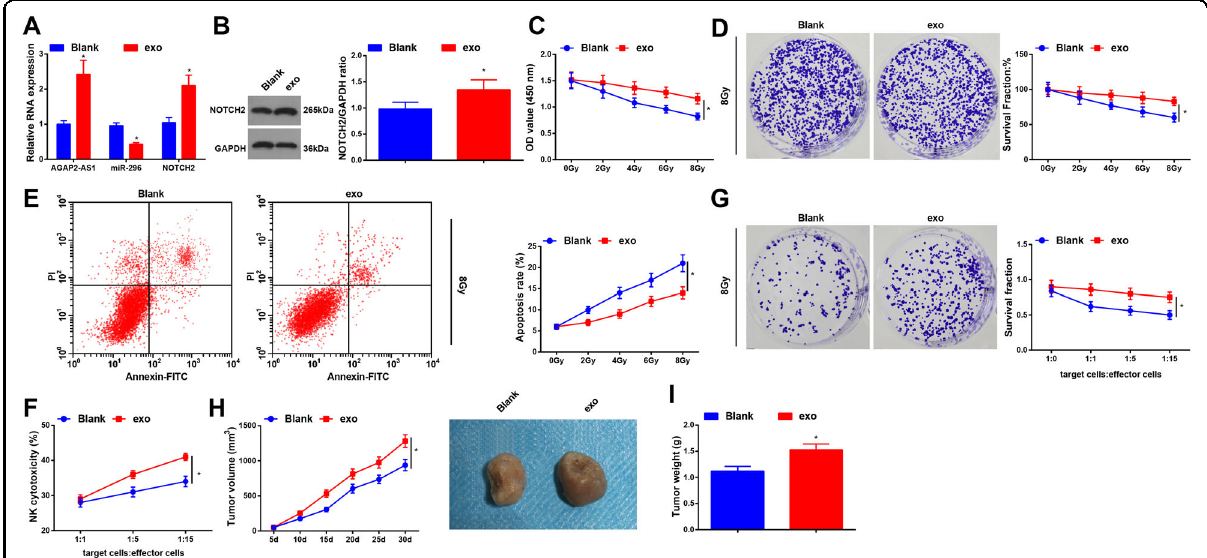
Fig. 5 Macrophage-derived exosomes strengthen radioresistance of radioresistant lung cancer cells. A Expression of AGAP2-AS1, miR-296, and NOTCH2 in A549R26-1 cells was detected by RT-qPCR. B Protein expression of NOTCH2 in A549R26-1 cells was determined by Western blot analysis. C Viability of radioresistant lung cancer cells A549R26-1 was measured using CCK-8 assay. D Colony formation ability of radioresistant lung cancer cells A549R26-1 was evaluated by colony formation assay. E Apoptosis of radioresistant lung cancer cells A549R26-1 was determined by fl ow cytometry. F NK cells-mediated cytotoxicity against radioresistant lung cancer cells A549R26-1 was detected by LDH cytotoxic assay. G NK cells- mediated cytotoxicity against radioresistant lung cancer cells A549R26-1 was detected by colony formation assay. H Volume of xenografts from nude mice that had been injected with radioresistant lung cancer cells A549R26-1; I , weight of xenografts from nude mice that had been injected with radioresistant lung cancer cells A549R26-1; N = 3 in the cellular experiment and n = 6 in the animal experiment; * P < 0.05 vs. the blank group in A549R26-1 cells; the measurement data were expressed as mean ± standard deviation, one-way ANOVA was used for comparisons among multiple groups and Tukey ’ s post hoc test was used for pairwise comparisons after one-way